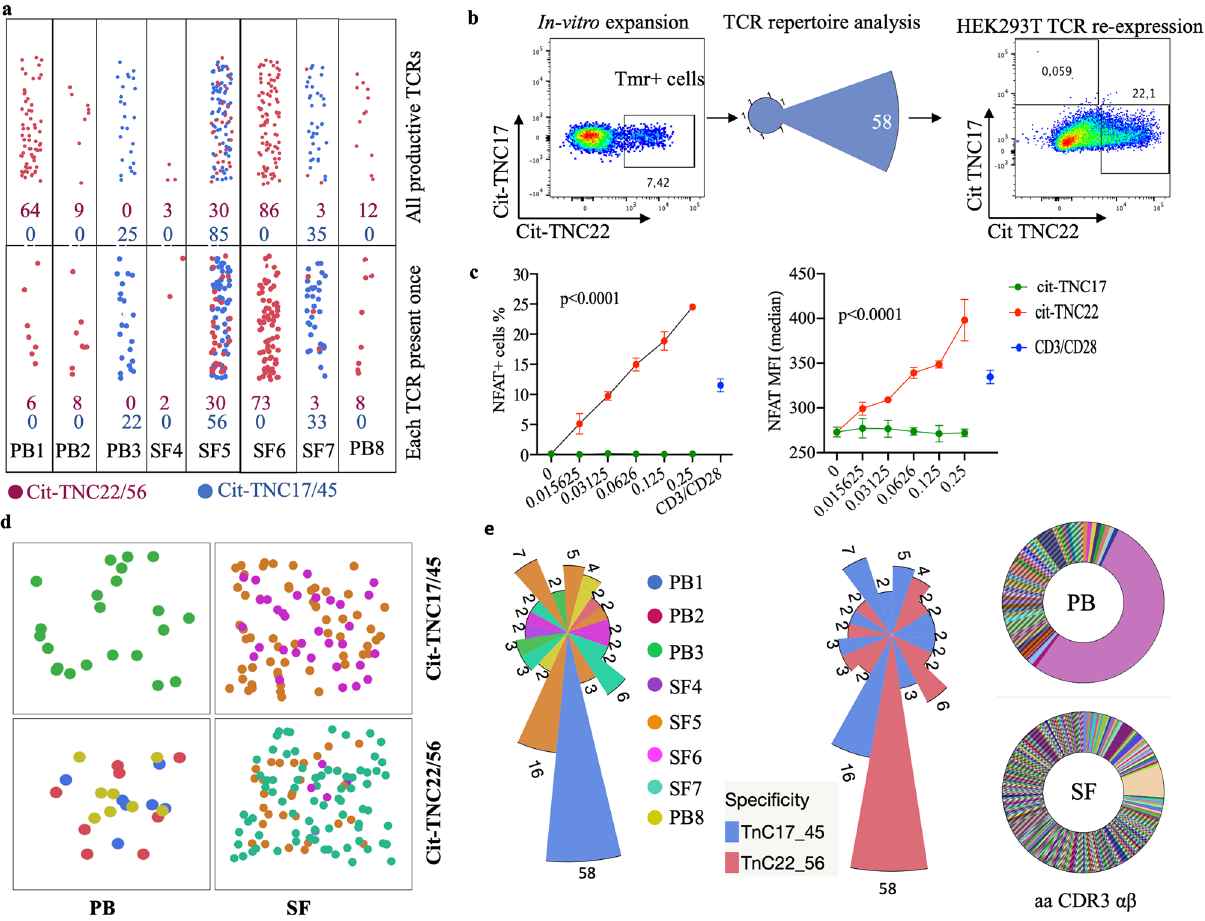
Figure 2. Identification and validation of antigen-specificity of cit-TNC specific TCRs: ( a ) The number of sorted cells that gave productive TCRs after sequencing are shown with cit-TNC22/56 specific cells in burgundy and cit-TNC17/45 specific TCRs in blue color (top panel). Clustering of TCRs using CDR3αβ amino acid sequences showed the exact number of TCRs obtained for the two specificity groups in each patient (bottom panel). Collectively, we could retrieve TCR sequences for cit-TNC17/45 specificity from 3 patients, and cit- TNC22/56 from 7 samples. ( b ) Demonstration of a cit-TNC22 specific CD4 + T cell expansion from peripheral blood. Tetramer staining at day 9 showed an expansion of cit-TNC22 specific CD4 + T cells, comprising one dominant TCR. Transient artificial re-expression of the TCR into HEK293T cells confirmed binding to its cognate tetramer (x-axis), but not to another epitope from cit-TNC17 (y-axis). ( c ) Stable re-expression of same TCR into 58αβ TCR-negative cell line expressing NFAT-GFP reporter demonstrated responsiveness towards cit-TNC22 loaded HLA-DRB1*04:01 monomers, both in proportion of NFAT + cells and of NFAT-GFP median fluorescence intensity (MFI) after stimulation with cit-TNC22 (red symbols) but not with the irrelevant cit- TNC17 peptide-monomer complexes (green symbols). Anti-CD3/CD28 stimulation is shown in blue color. X axis depicts different amounts of peptide-monomer complexes used for coating the plates. ( d ) Figure shows the recovery of TCRs belonging to each of the two specificity groups (cit-TNC17/45 or cit-TNC22/56) from both PB and SF from different patients, where each color represents TCRs derived from a different patient. ( e ) First panel shows TCR repertoire of expanded cit-TNC specific T cells. In total, 19 expanded TCR clones were found in 8 RA patients (4 PB, 4 SF), with varying extent of expansion. Each color in the figure indicates TCRs coming from different patients. Second panel shows all expanded TCRs in context of fine-specificity group (red = cit- TNC22/56 specific, blue = cit-TNC17/45 specific). Among the expanded clones, 9 TCR clones were specific for cit-TNC22/56, while 10 were cit-TNC17/45 specific. Last panel shows the extent of expansion of TCR clones within PB (top) and SF (bottom) compartments, where both sites showed expanded TCR repertoire, but not in that of cit-TNC17/45 specific repertoire, in patients (Fig. 3d, suppl_fig.3b). Separate analy- sis of PB and SF derived TCRs also showed over usage of TRBV20-1 for cit-TNC22/56 specific repertoire (suppl_ fig.4). TRBV20-1 was the most utilized gene segment both when analyzing all cit-TNC22/56 specific TCRs (present in 28 TCRs from 5 of 7 patients), (suppl_fig.4) as well as TCRs from the expanded clones (Fig. 3e). Such prominent TRBV20-1 bias was not observed amongst influenza-specific T cells (Suppl_fig.3c). Such similarities in TCR usages further strengthens the idea of antigen driven changes in TCR repertoire.